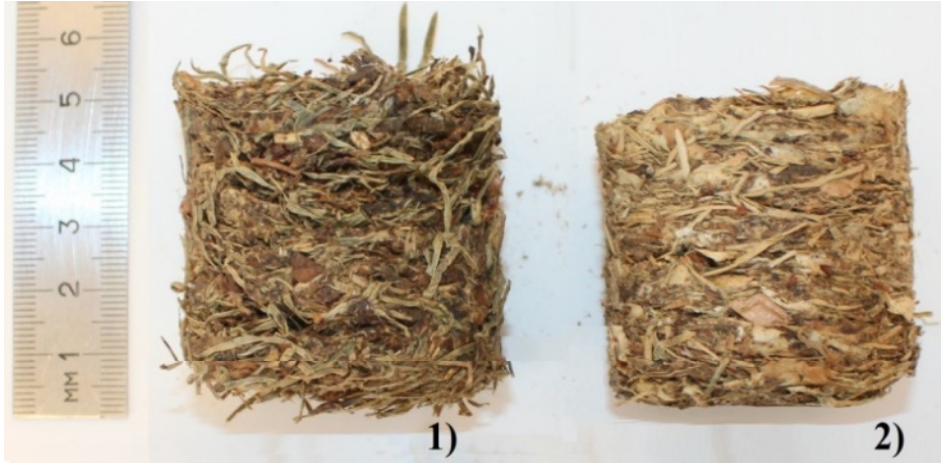
Figure 3. Briquettes from the shredded chips of forest residues from the primary composition, formed at a temperature of ( 1 ) 22 °C and ( 2 ) 73 °C.